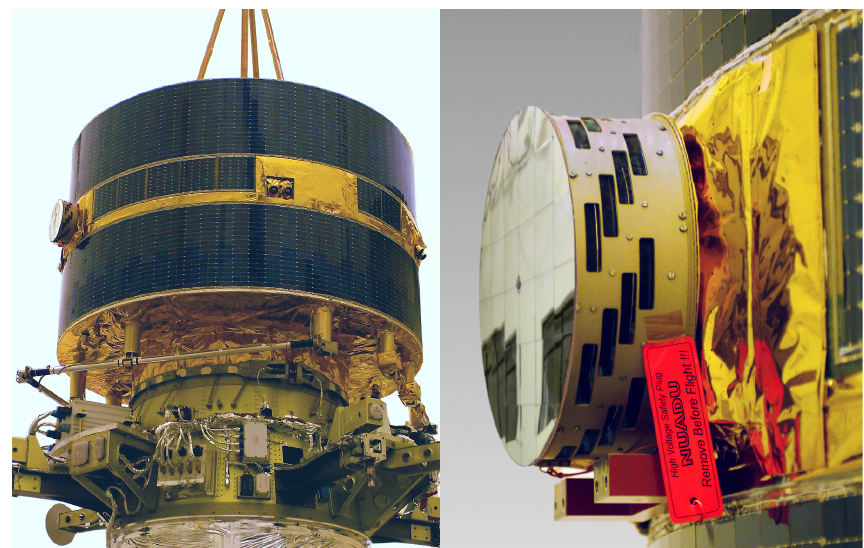
Fig. 9. (Left) view of the TC-2 spacecraft before launch, showing the position of NUADU on board; (right) close up view of NUADU, showing the input apertures and the quartz Optical Solar Reflectors (OSRs) mounted on the outer surface of the Sensor